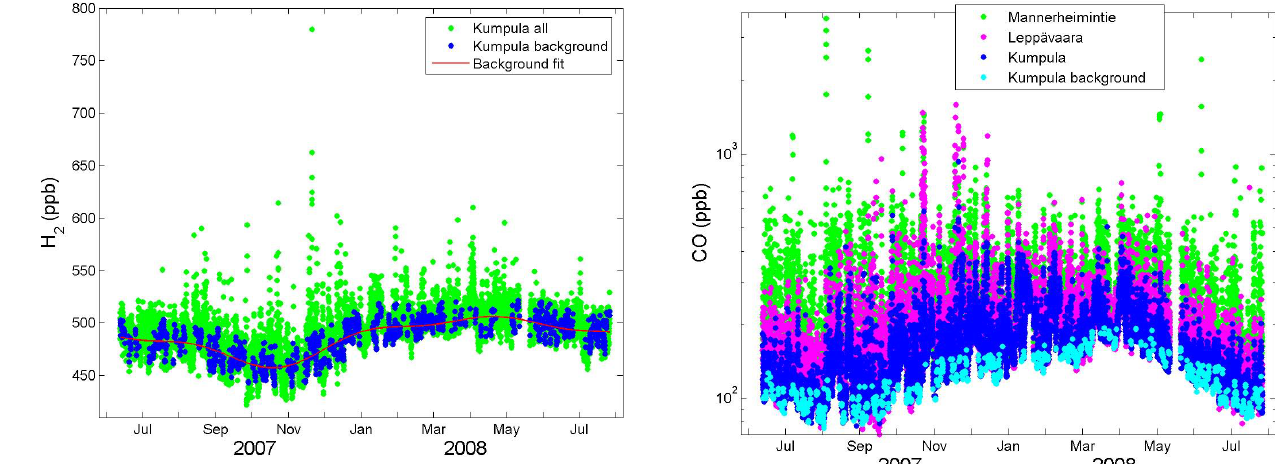
Fig. 3. Hourly means of carbon monoxide mixing ratios at three sites in Helsinki region. Kumpula background refers to selected hourly values. Mannerheimintie and Lepp¨avaara data provided by YTV Helsinki Metropolitan Area Council.